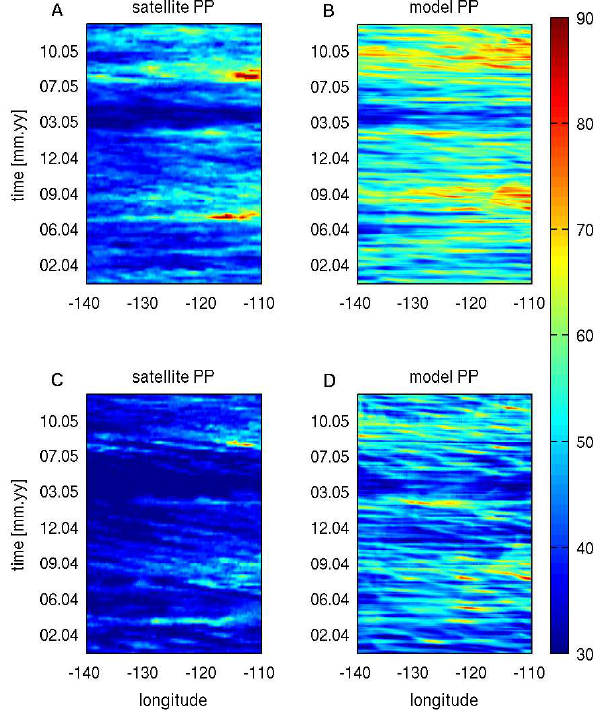
Fig. 6. Time–longitude diagrams of depth integrated and merid- ional average model and satellite PP in the EEP. Time period is from January 2004 to December 2005. Top panels (A, B) show PP averaged over 1 ◦ S–1 ◦ N and bottom panels (C, D) show PP aver- aged over 1 ◦ N–3 ◦ N. (A, C) standard VGPM satellite estimate of PP (mmolCm − 2 d − 1 ) based on Behrenfeld and Falkowski (1997); (B, D) ROMS–CoSiNE PP (mmolCm − 2 d − 1